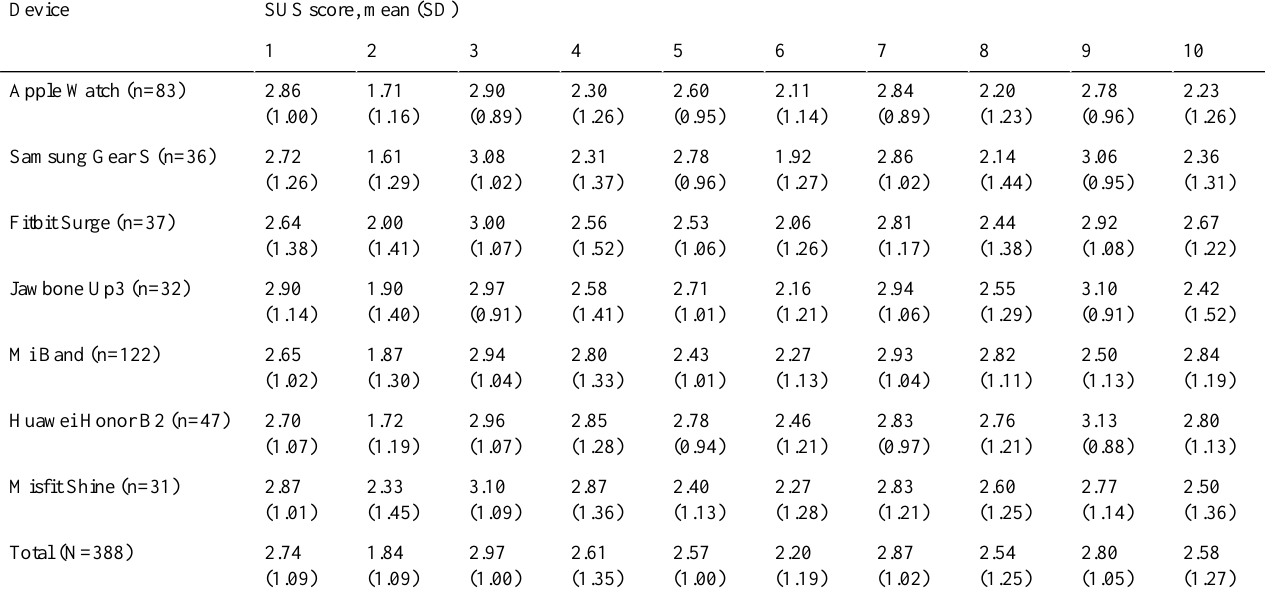
Table 5. Mean System Usability Scale (SUS) score for each question and